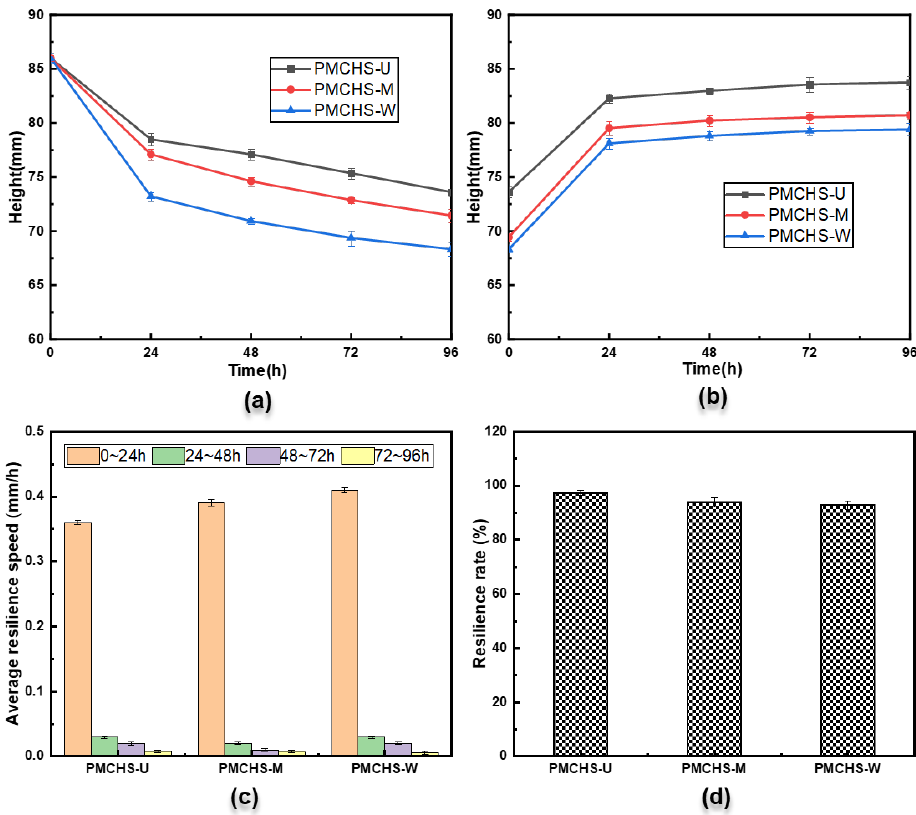
Figure 6. ( a ) Time–height curves of three types of PMCHSs during loading, ( b ) time–height curves of three types of PMCHSs during unloading, ( c ) resilience speed of three types of PMCHSs, and ( d ) resilience rate of three types of PMCHSs.